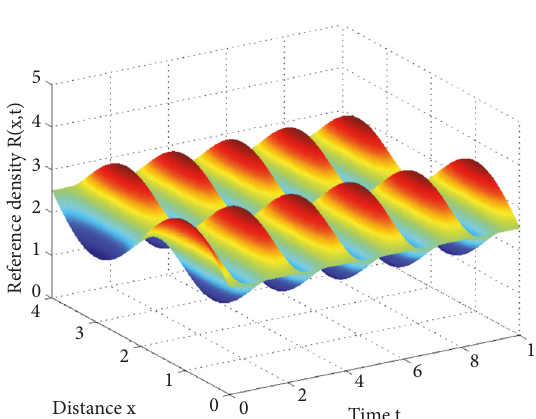
Figure 6: Reference density 𝑅 = 2.5 + sin (0.5𝜋𝑥) cos (𝜋𝑡) .